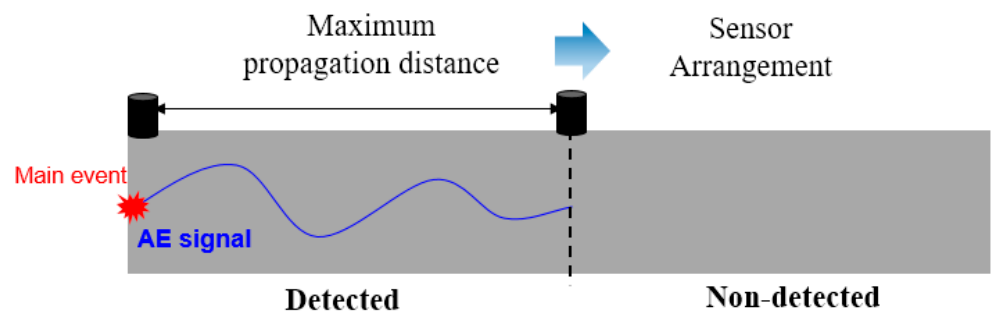
Figure 2. Wave propagation distance of an AE monitoring system in concrete structures.